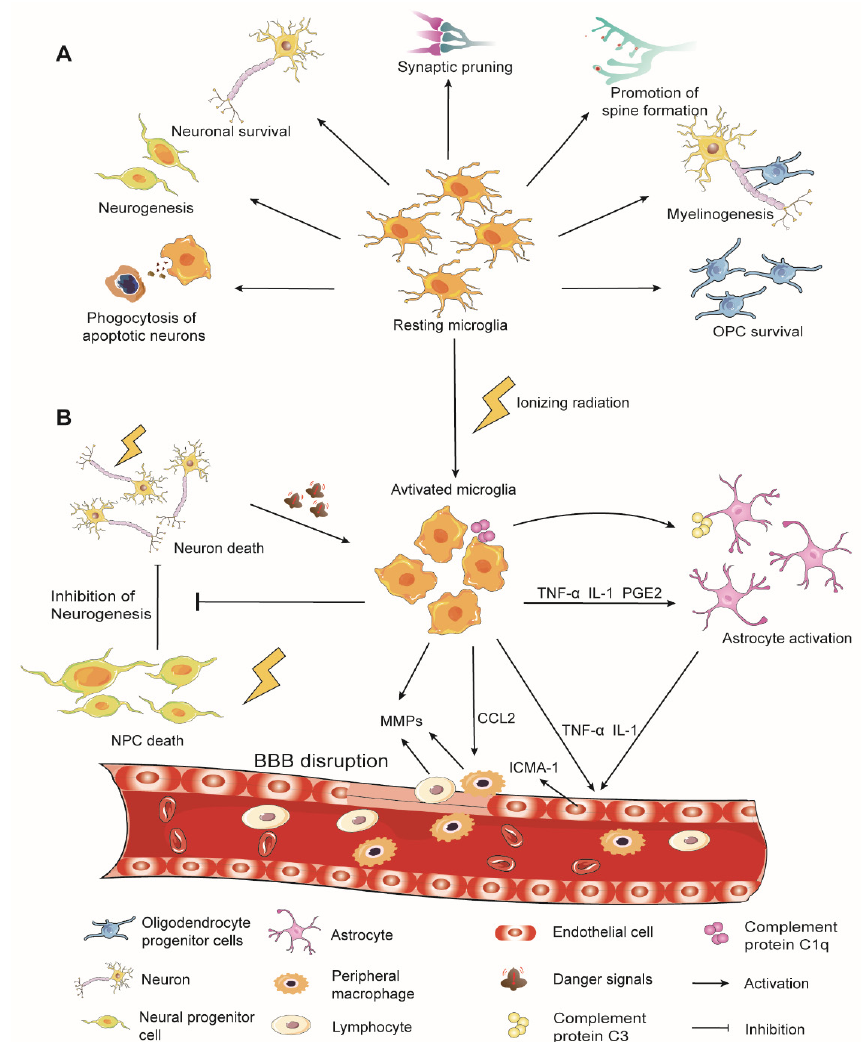
Figure 1. Overview of the role of microglia in healthy brain and radiation-induced brain injury (RIBI). ( A ) Physiological functions of microglia in healthy brain. ( B ) The interaction of activated microglia with central nervous system (CNS) cell populations mediates the development of RIBI. Ionizing radiation (IR) directly induces microglial activation, while irradiated neurons and endothelial cells (ECs) release “danger” signals (high mobility group box 1, adenosine triphosphate, uridine diphosphate, and so on) to exacerbate microglial activation. By participating in complement cascade and secreting pro-inflammatory mediators such as TNF- α , interleukin-1 (IL-1), and prostaglandin E2 (PGE2), activated microglia can trigger the astrocytes activation, prevent neurogenesis and neural progenitor cell (NPC) differentiation, and stimulate the expression of intercellular adhesion molecule 1 (ICAM-1) in endothelial cells. ICAM-1 accumulation and blood–brain barrier (BBB) damage induced by IR cause the increased infiltration of peripheral immune cells, and this is exacerbated by monocyte chemoattractant protein-1 (MCP-1/CCL2) secreted by microglia. Subsequently, matrix metalloproteinases (MMPs) secreted by microglia and infiltrating cells further aggravate BBB damage.